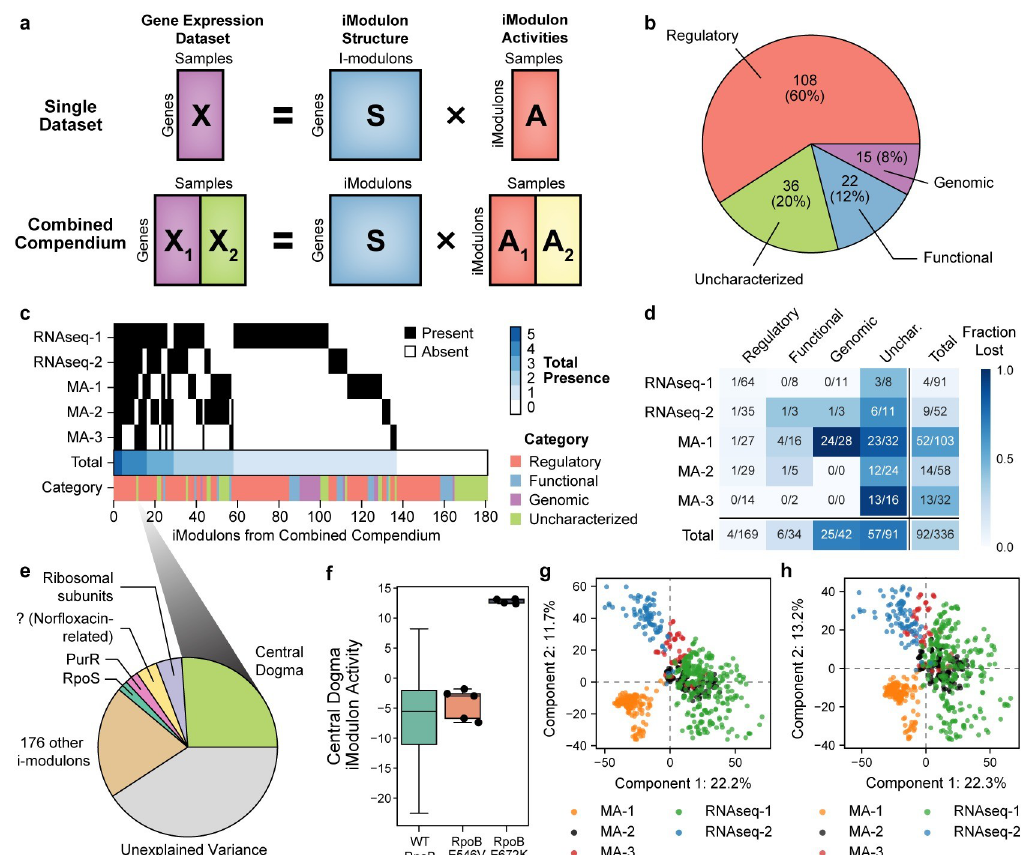
Fig 5. Decomposition of combined compendium results in increased resolution (A) Schematic illustration of data integration. (B) Pie chart showing the categories of the 181 iModulons from the combined dataset. (C) Heatmap illustrating which iModulons from the combined compendium were matched to iModulons in individual datasets in the RBH graph. The total number of matches for each iModulon is shown in blue. Category of each iModulon is shown below. (D) Heatmap illustrating how many iModulons from each category and dataset were not matched to an iModulon in the full compendium in the RBH graph. (E) Pie chart illustrating the fraction of expression difference resulting from ppGpp-RNAP binding explained by each iModulon. The norfloxacin-related iModulon is described in S7E Fig. (F) Boxplot of the Central Dogma iModulon activities for expression profiles in the RNAseq-1 dataset. (G) Principal component loadings of the combined compendium expression levels without batch correction. (H) Principal component loadings of the iModulon activities from the combined compendium.